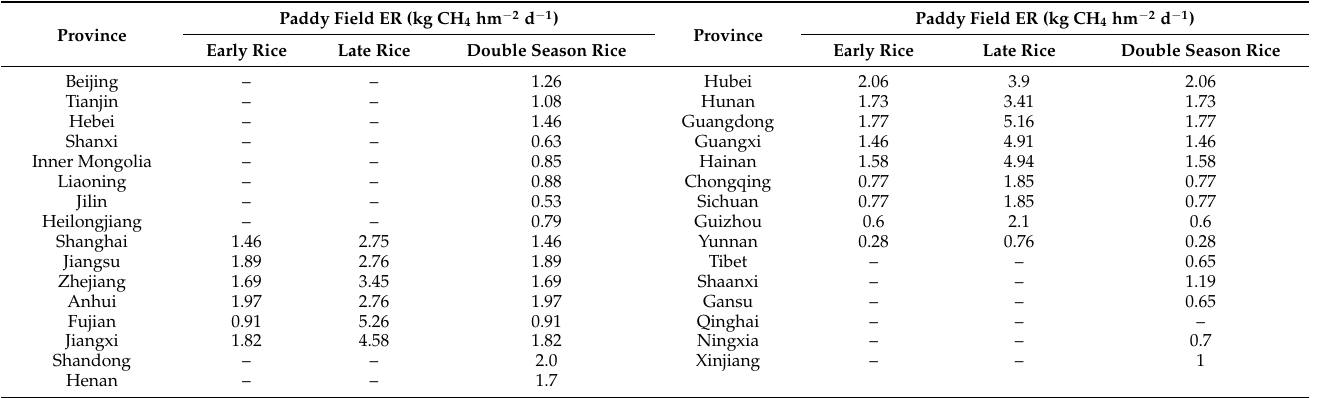
The data in Table 4 come from the literature